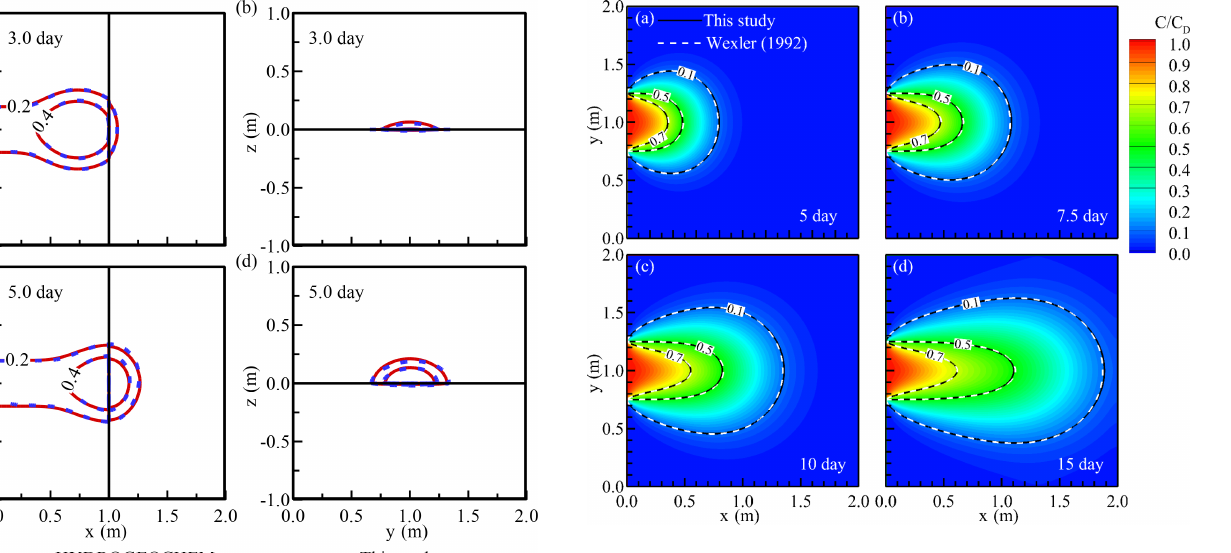
Figure 8. The comparison of solute transport for a continuous inlet source in a 2-D horizontal porous fracture at (a) 5.0, (b) 7.5, (c) 10.0, and (d) 15